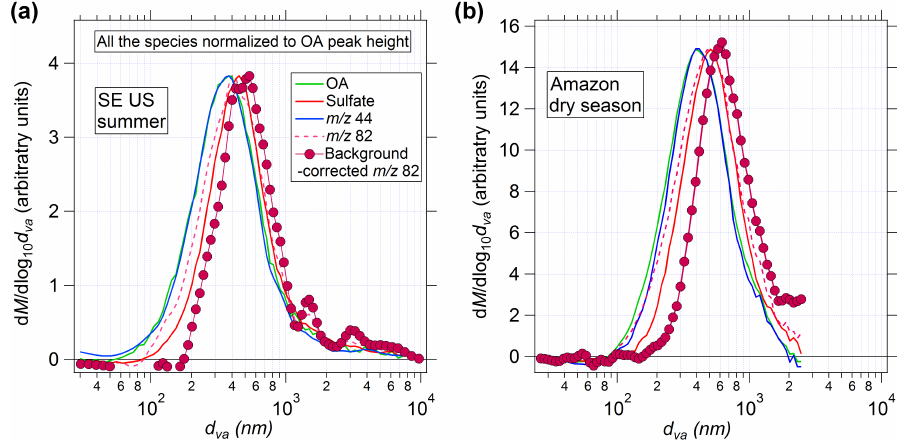
Figure 8. Average mass-weighted aerodynamic size distribution of OA, sulfate, m/z 44, and m/z 82 in (a) SE US and (b) Amazon. The mass size distribution of m/z 82 with background correction is also shown. The background correction method was introduced in Hu et al. (2015). Heights of all the size distributions are set to the same value for ease of visual